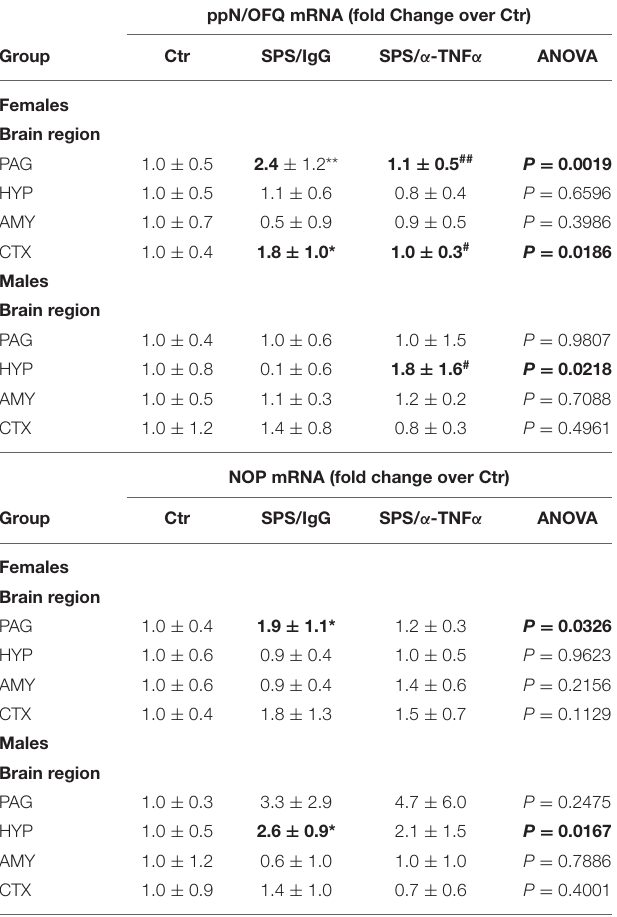
TABLE 2 | Effects of α -TNF antibody treatment on SPS-induced changes in ppN/OFQ and NOP mRNA from Day 9 post-SPS and control rats. ppN/OFQ mRNA (fold Change over